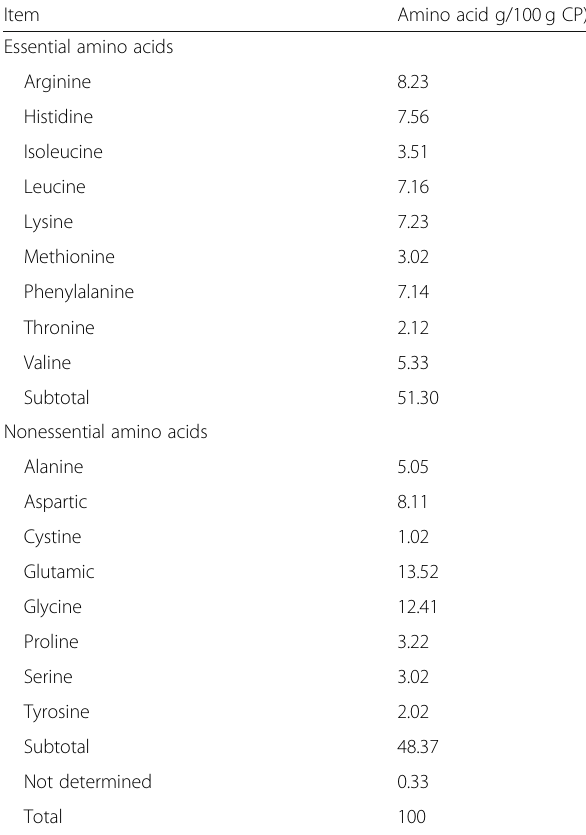
Table 1 Chemical analysis of yellow corn and dried pomegranate peel